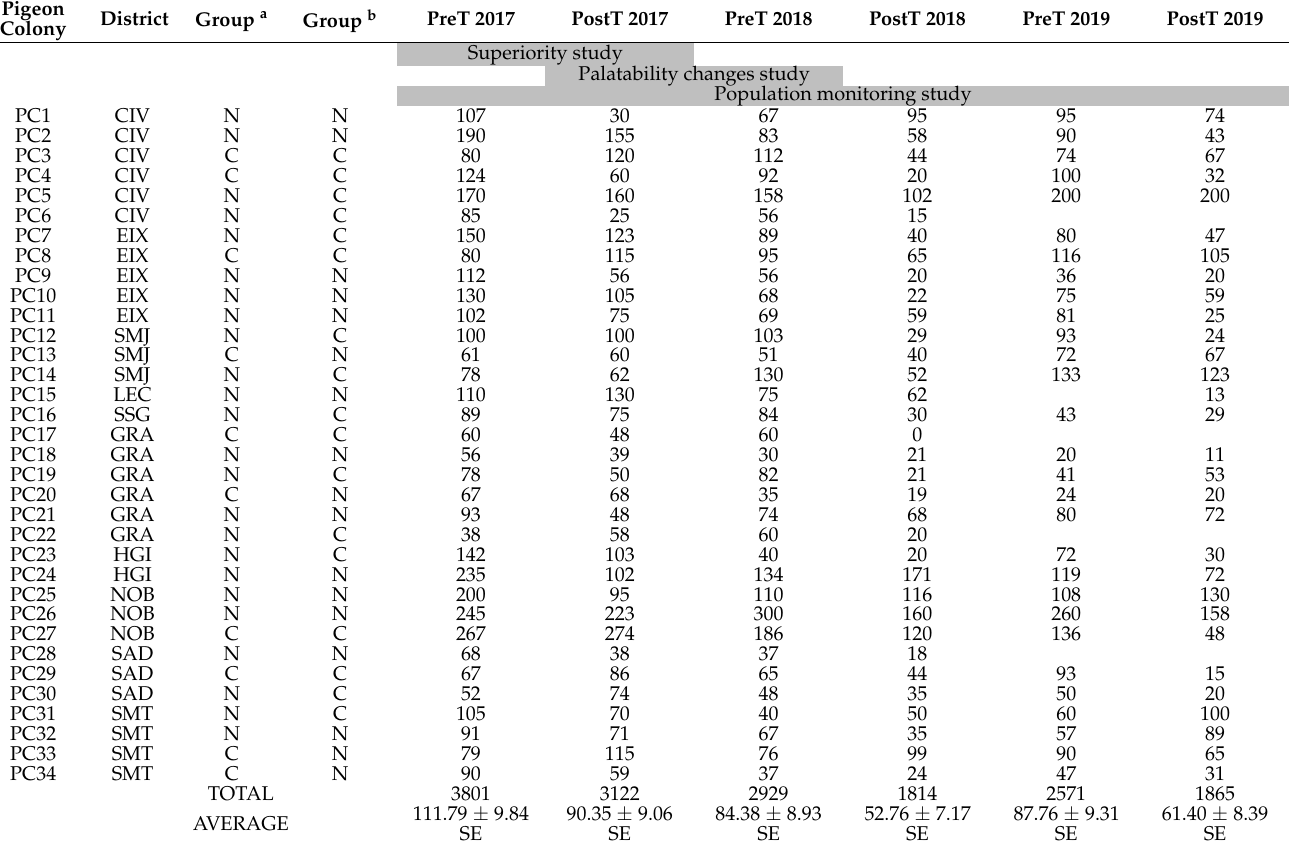
Table 1. Scheme of the study design and maximum number of pigeons recorded in the pre-treatment (PreT) and post-treatment (PostT) censuses during the study period. Group (N, nicarbazin; C, control). District (Ciutat Vella, CIV; Eixample, EIX; Sants-Montjuïc, SMJ; Les Corts, LEC; Sarria-Sant Gervasi, SSG; Gr à cia, GRA; Horta-Guinard ó , HOG; Nou Barris, NOB; Sant Andreu, SAD; Sant Mart í ,